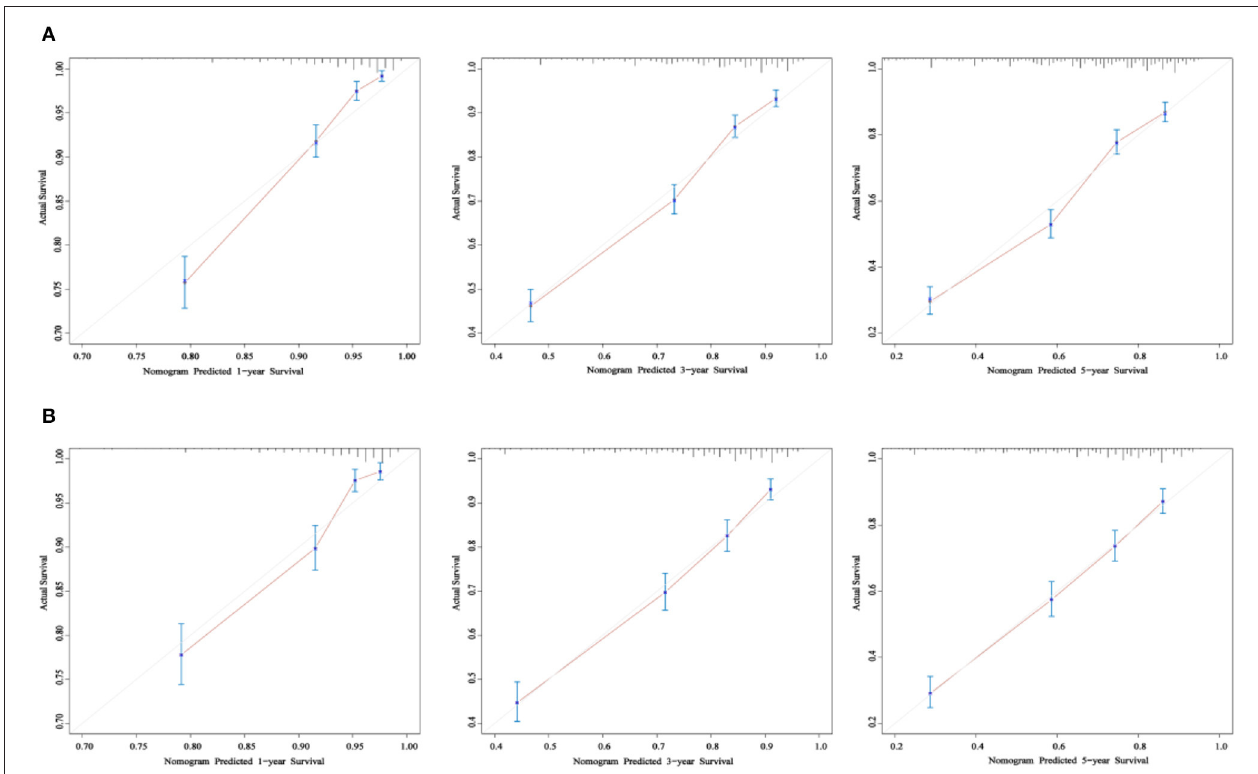
FIGURE 4 | The calibration curve of OS at 1-, 3-, and 5- years for the training cohort (A) and the validation cohort (B) . The x-axis refers to the probability of survival and the y-axis means actual survival. The gray lines represent the perfect calibration models in which the predicted probabilities are identical to the actual probabilities.